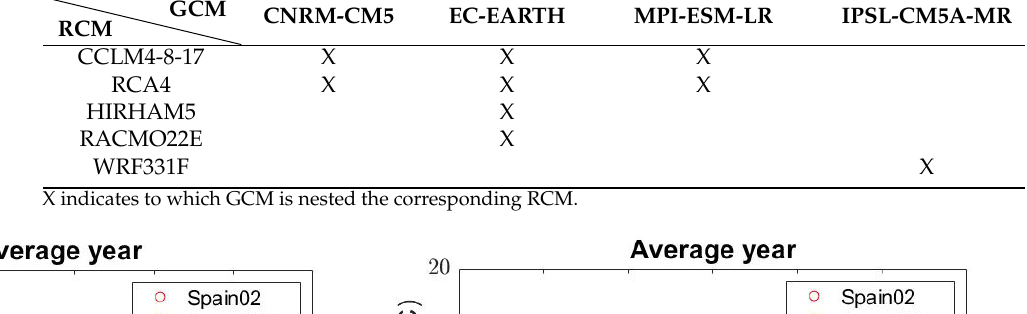
Table 1. Selected Regional Climate Models (RCM) and Global Climate Models (GCM). GCM CNRM-CM5 EC-EARTH RCM